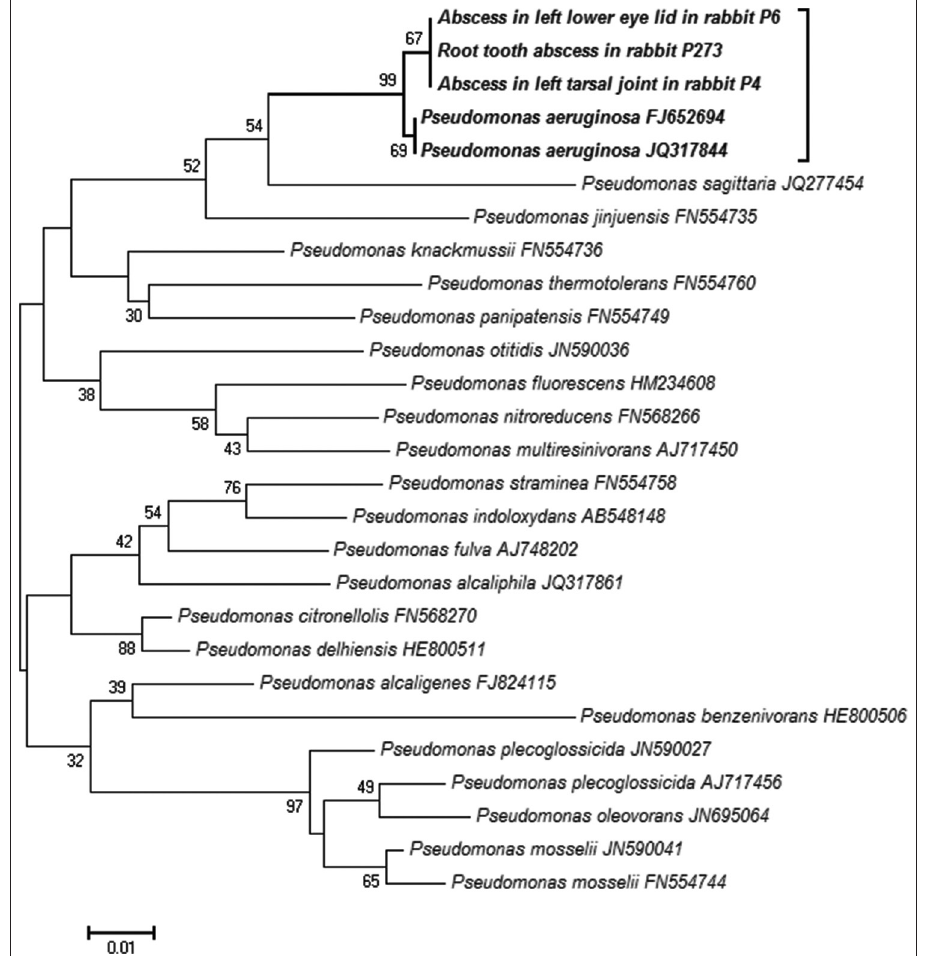
Figure-1: Neighbor-joining phylogenetic tree of the rpoB gene of Pseudomonas species detected in the abscesses (GenBank accession number; MG917661-MG917663) and validated genotypes of Pseudomonas species .